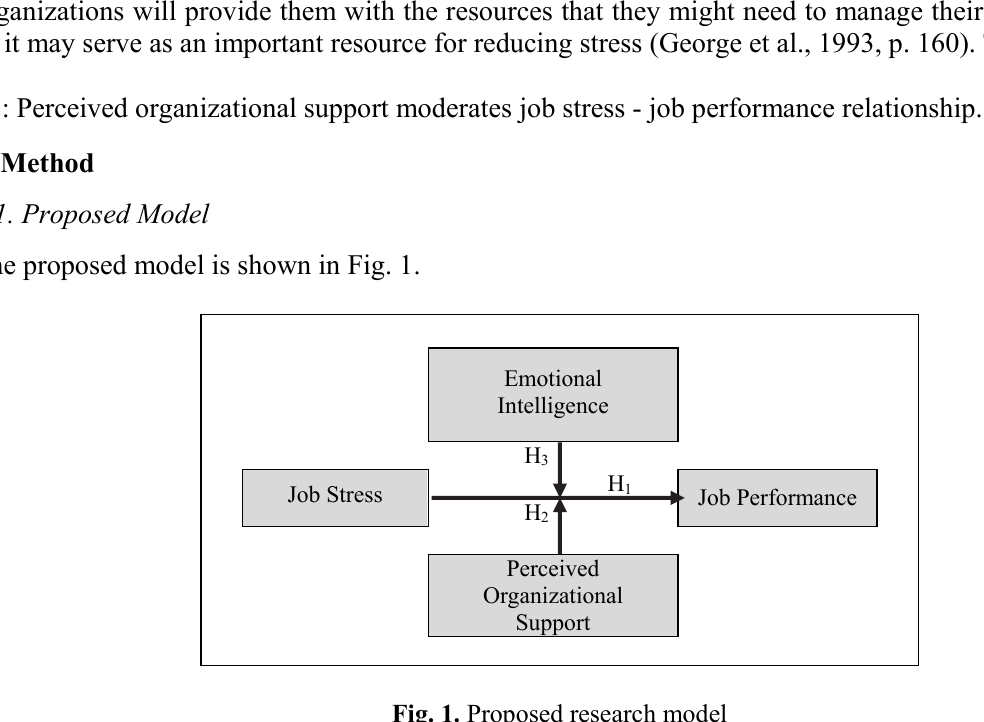
Fig. 1. Proposed research